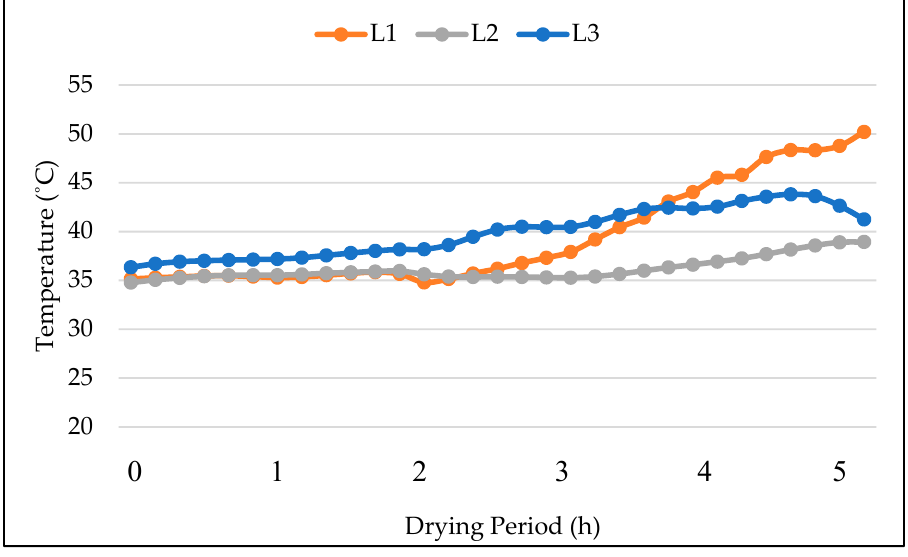
Figure 7. Moisture content variation with time at the inner and outer sections of the dryer. Variations in the moisture content of grains sampled transversally across the drying chamber could be attributed to variation in the drying air temperature. It is forced through the drying bed with all the grains not fully exposed to the same drying air condition which is established by plenum. As demonstrated in Figure 8, the grain mass at the inner section